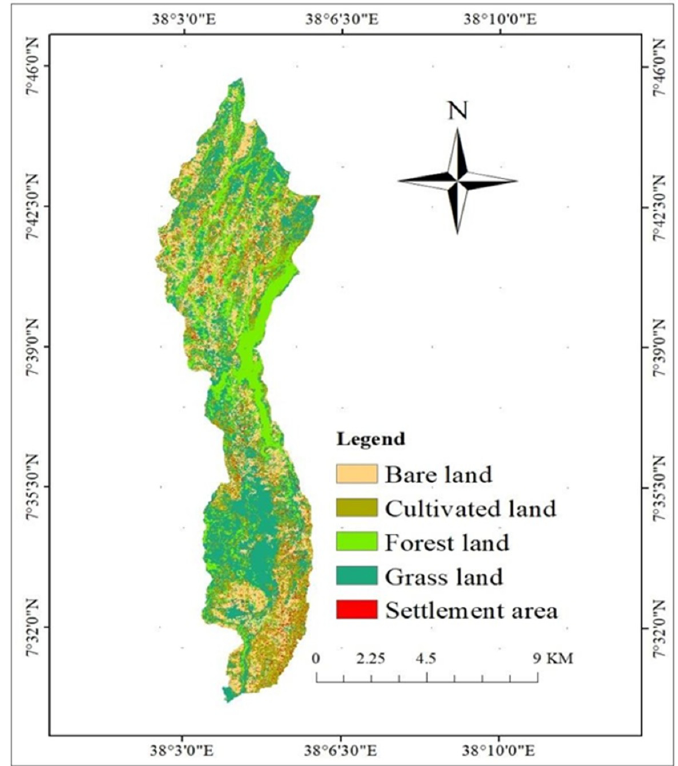
Figure 3. Matenchose watershed LULC Map of 1991. The settlement area showed the highest percentage of positive change (10.08%). The second-highest rate of change was seen on cultivated land, whereas the rate of change on bare land was only marginally positive (0.75%). In contrast, the study period between 1991 and 2003 saw a negative rate of change for both grassland ( − 17%) and forestland ( − 77%) respectively. Additionally, the yearly rate of LULC variation between 2003 and 2020 has shown positive rates of change for both cultivated land and settlement areas. Settlement area has shown the highest positive rate of change (6.41%), followed by cultivated land (2.76%), while grassland ( − 4.29%), bare land ( − 0.82%), and forestland ( − 2.7%) displayed negative rates of change throughout the research (Figure 4).